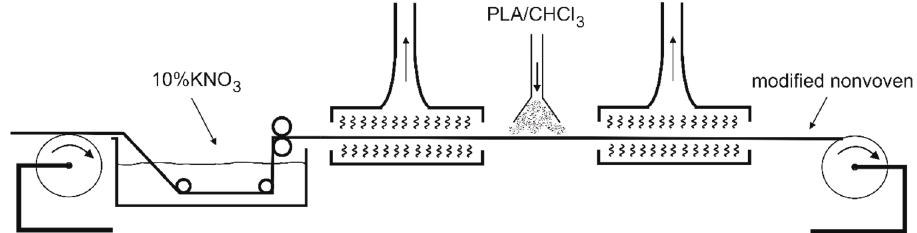
Figure 2. Diagram of the viscose nonwoven C modification process.